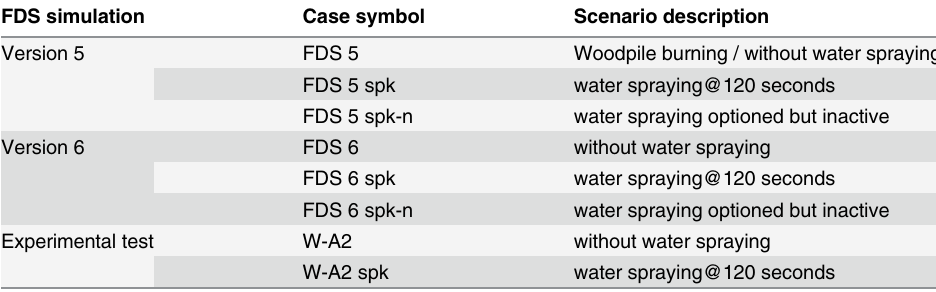
Table 1. Description of experiment and numerical simulation